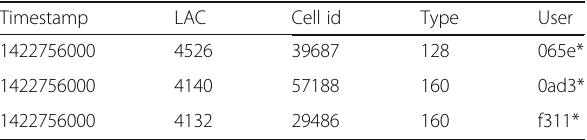
Table 1 Structure of CDRs data